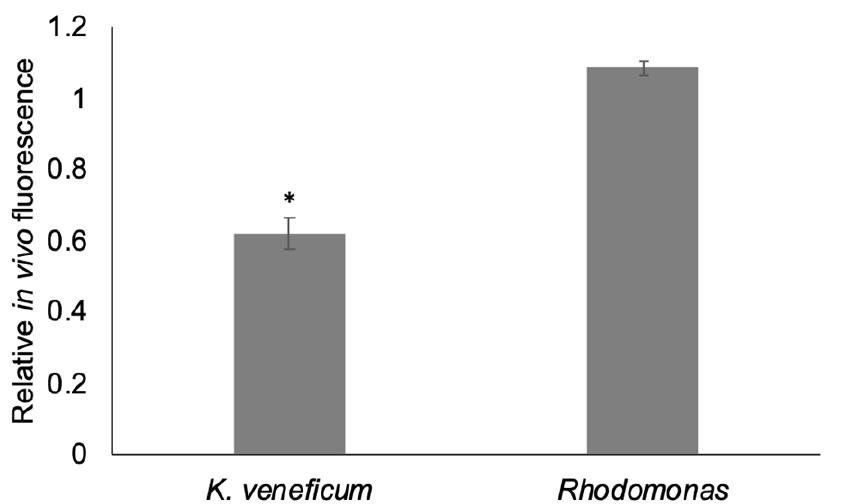
Figure 1. In vivo fluorescence of Karlodinium veneficum and Rhodomonas sp. in the algicide treatments (with IRI-160AA) relative to controls after 19 h of exposure. Error bars indicate standard deviations of 3 replicates. Asterisks indicate a significant difference of relative in vivo fluorescence of the indicated treatments compared to the controls ( p < 0.05).